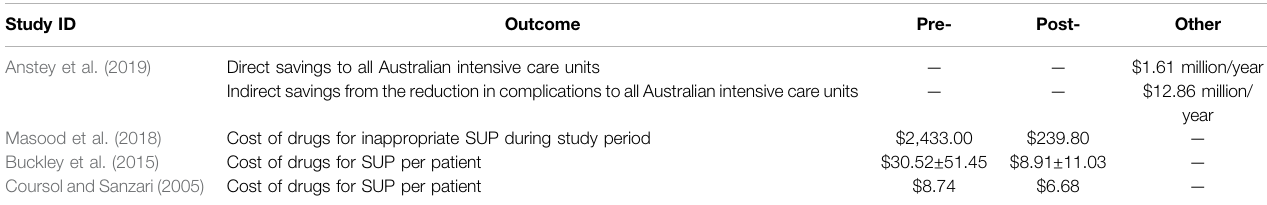
TABLE 7 | Economical outcomes related to